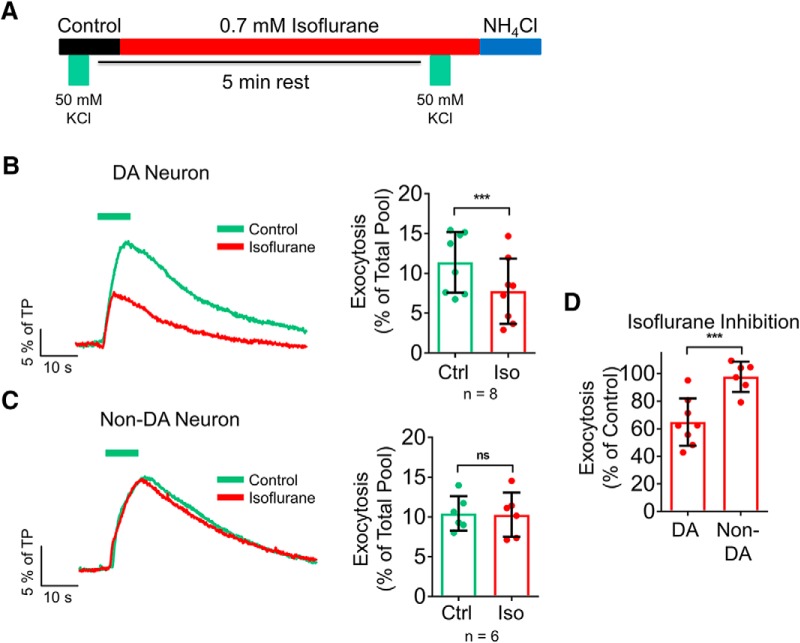
Isoflurane differentially inhibits SV exocytosis in dopaminergic neurons via a Nav-independent mechanism. A, Schematic of protocol using a pulse of 50 mM KCl (with an equivalent reduction in NaCl, green bars) to induce exocytosis in the absence or presence of isoflurane. B, C, Mean values of vMAT2-pHluorin response amplitudes in control and 0.7 mM isoflurane-treated neurons stimulated with elevated KCl. Traces show representative raw traces from a dopaminergic (DA) and non-dopaminergic (non-DA) neuron; ***p < 0.001; ns, not significant by two-tailed paired t test. D, Comparison of the effect of isoflurane on KCl-evoked exocytosis; ***p < 0.001 by one-tailed t test.